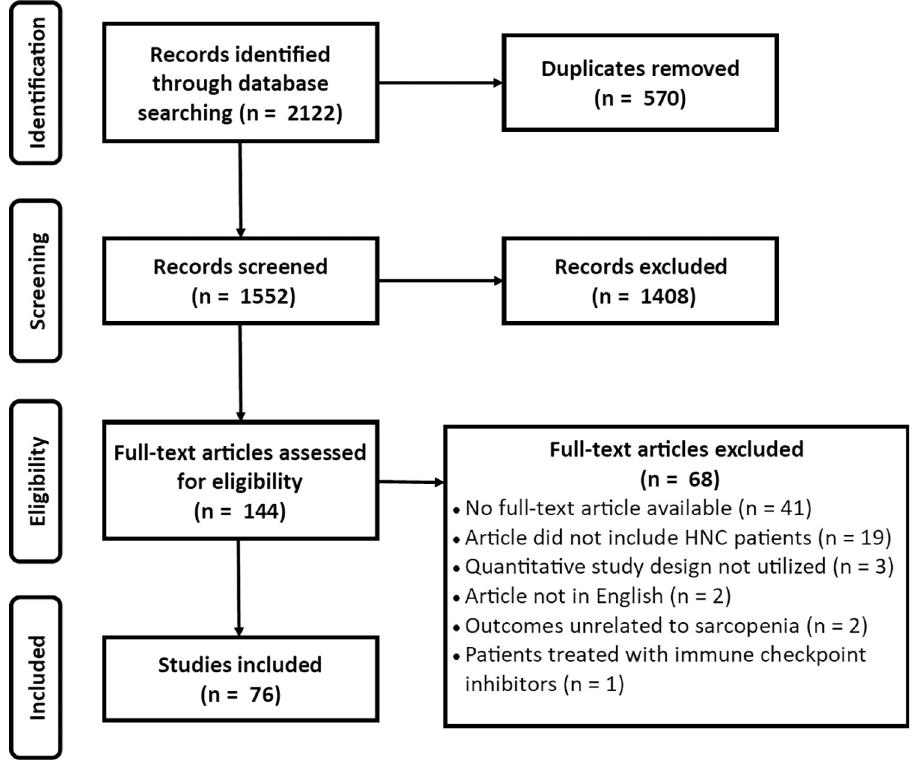
Fig 1. PRISMA flow chart for the scoping review